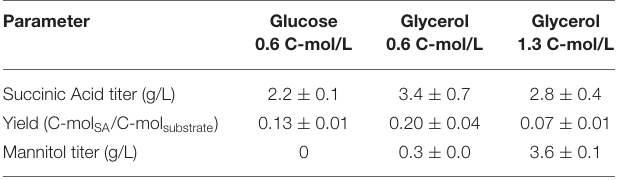
TABLE 2 | Shake flask fermentation results of ST8578 on YP media supplemented with 1.3 C-mol/L glycerol (40 g/L), 0.6 C-mol/L glycerol (18.5